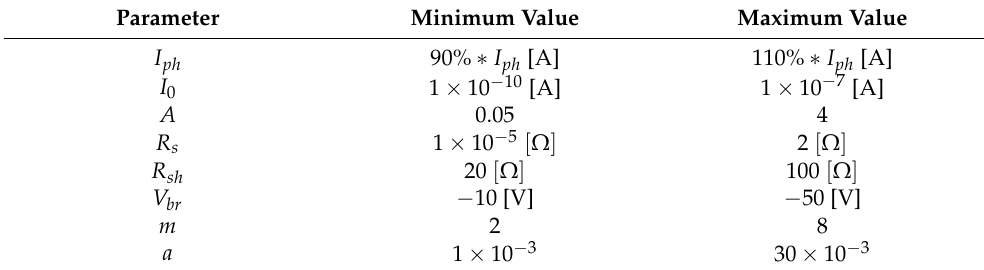
Table 3. Parameter constraints.